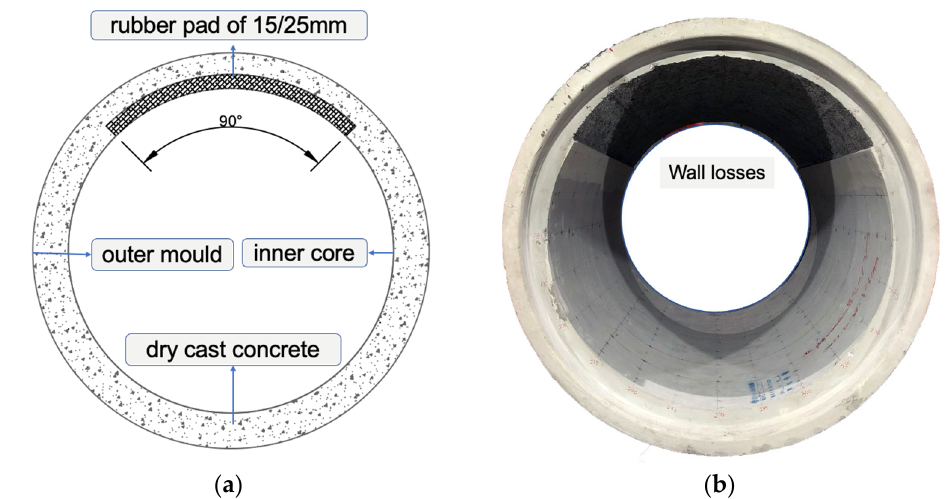
Figure 3. A prefabricated RCP with simulated uniform corrosion defects. ( a ). Schematic diagram of section layouts during casting. ( b ). Photograph of a manufactured pipe with wall losses. Table 1. Specifications of the reinforced concrete pipes in this